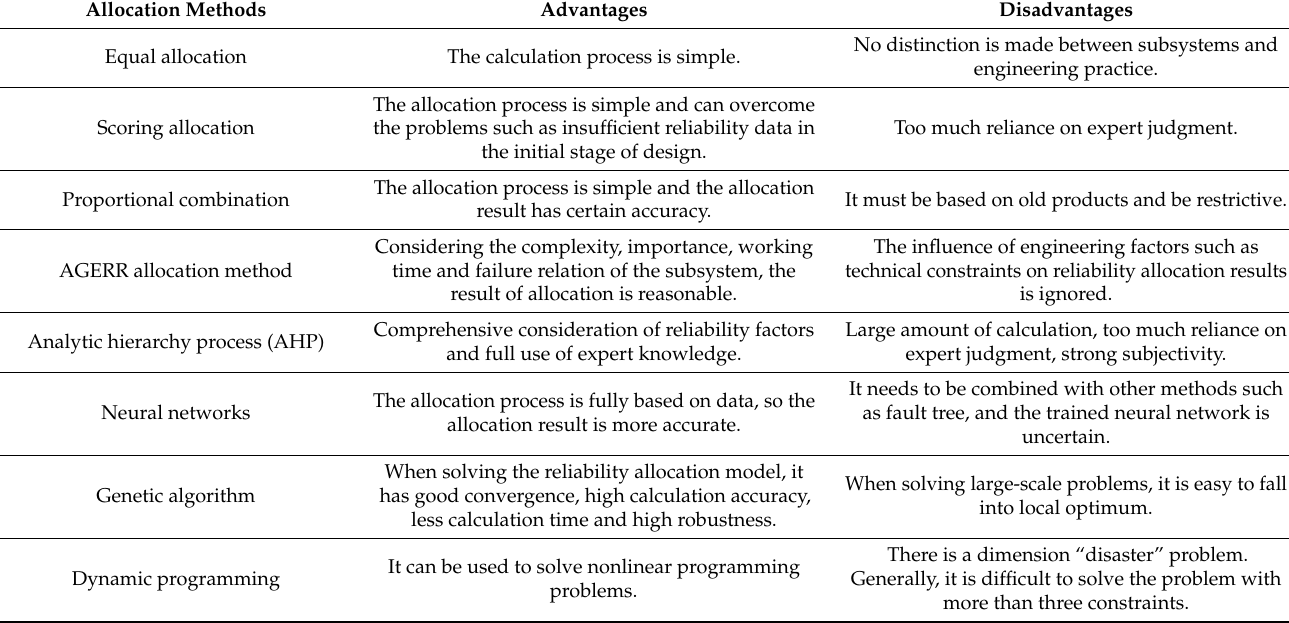
Table 1. Advantages and disadvantages of different allocation